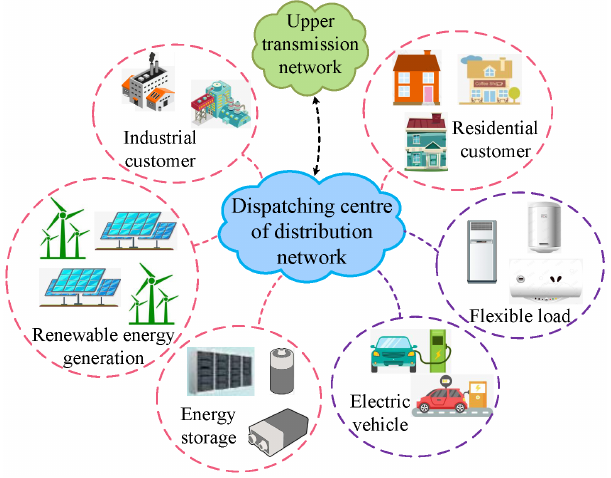
Figure 1. Schematic of distribution network